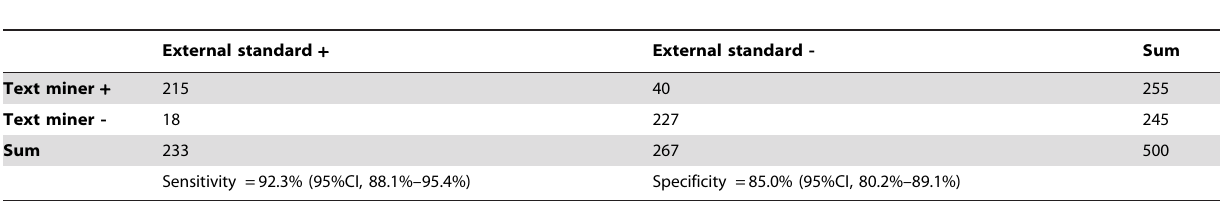
Table 3. From a random sample of 500 companion animal cases of diarrhea, the accuracy of the text miner for classifying the cases as positive or negative for ‘ had an antimicrobial administered, dispensed or prescribed ’ when compared to a manual review of the medical records serving as the external standard.